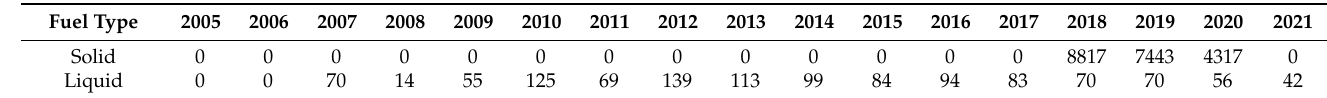
Table 2. Statistics of imported biomass-based fuels in Taiwan a